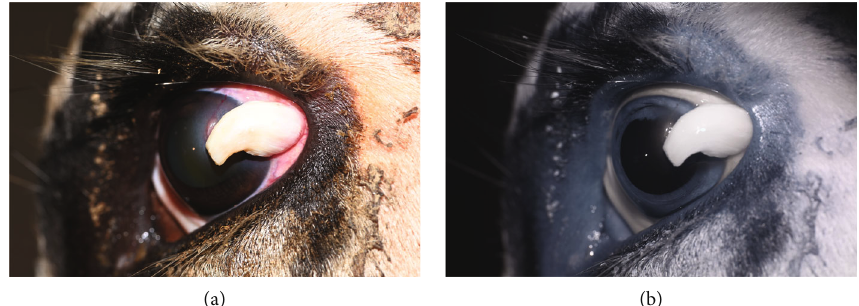
Figure 1: Color (a) and infrared (b) imaging of the limbal mass on initial examination of the left